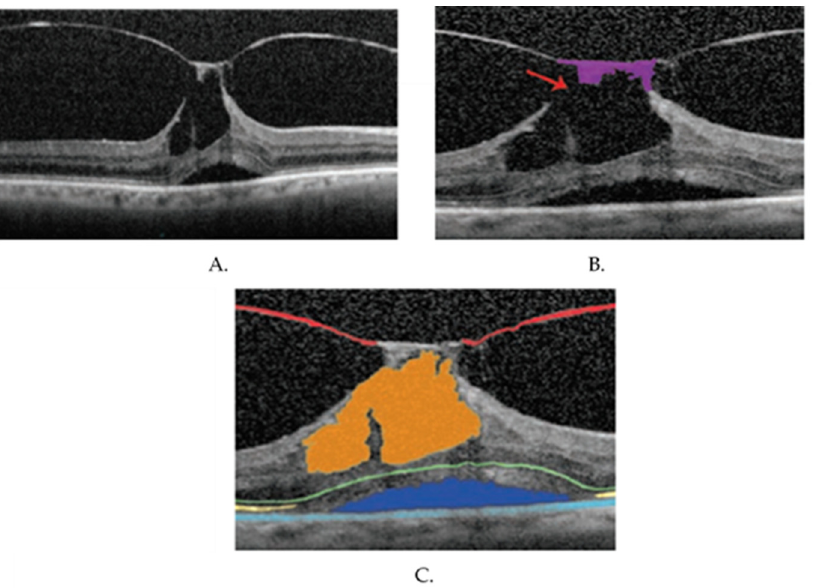
Figure 8. Extreme VMT causing foveal cysts: ( A ) VMT caused by partial PVD; ( B ) segmentation of roof of retina; ( C ) segmentation of PVD, subretinal fluid, and cyst.